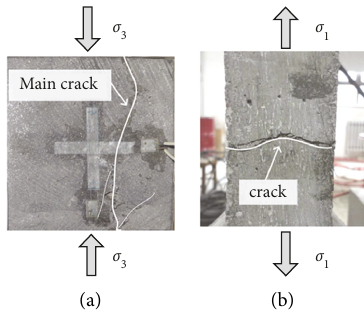
Figure 5: Failure modes of RPC under (a) uniaxial compression and (b) uniaxial tension loading.